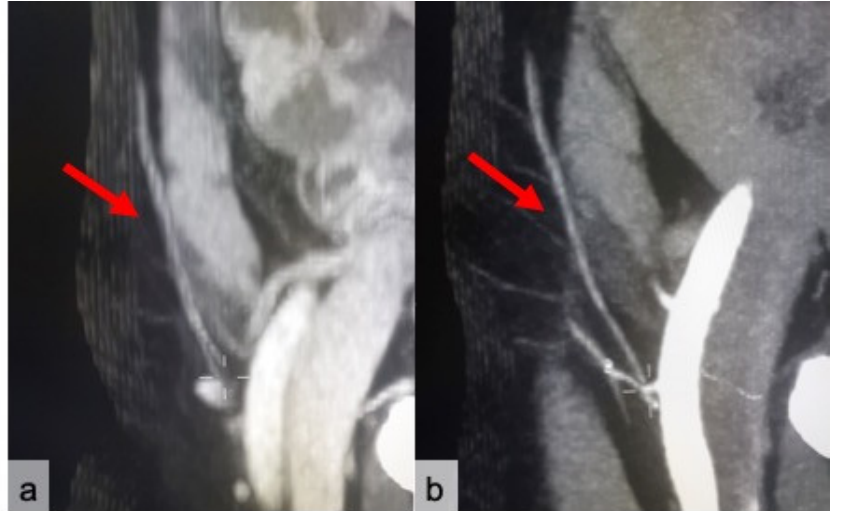
Figure 5. Assessment of the SIEA caliber compared to the dominant perforator. cCT ( a ) and CTa ( b ) sub-volume sagittal MIP reconstructions show a SIEA (red arrows) with a 2 score (equal to the dominant perforator).